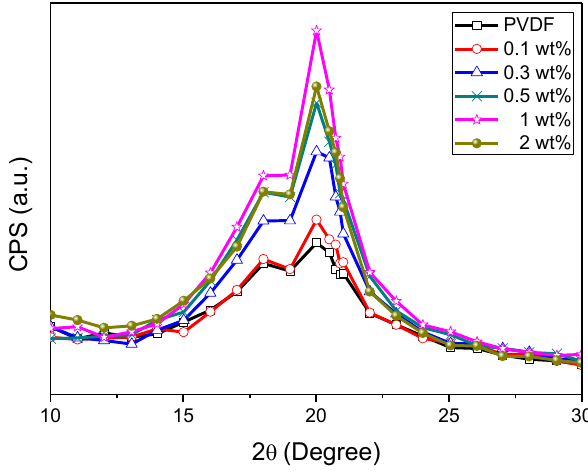
Figure 13. The XRD analysis of 10 wt% PVDF film with different wt% GO doping (0.0, 0.1, 0.3, 0.5, 1.0, and 2.0).